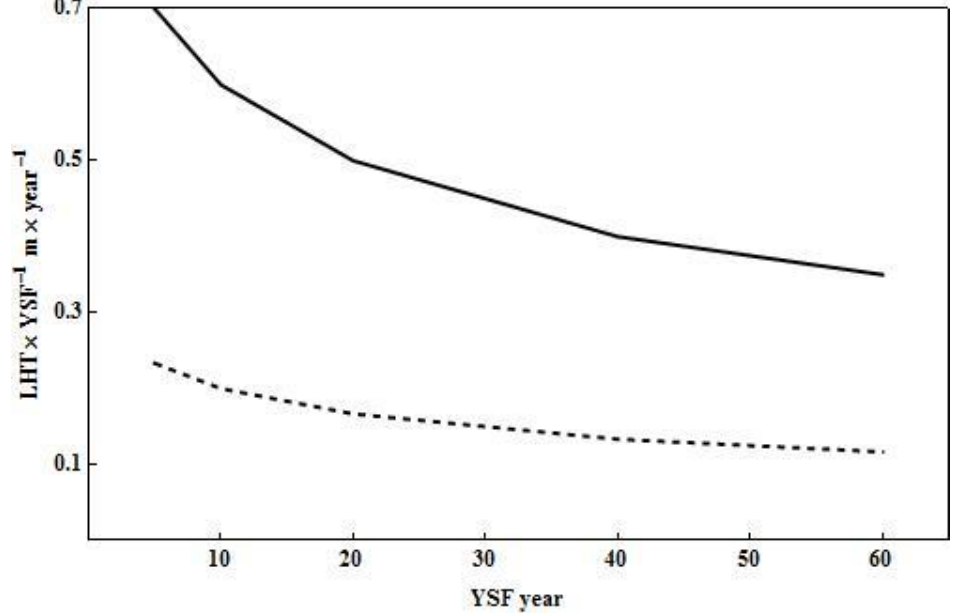
Figure 2 . Expected 95%-tile (full line) and 5%-tile (dashed) of average annual growth rate in mean canopy height ( LHT m × year −1 ) in 1920 field plots in the Boreal, Taiga Shield, and Taiga Cordillera ecozones located to the south of the studied historic fires.